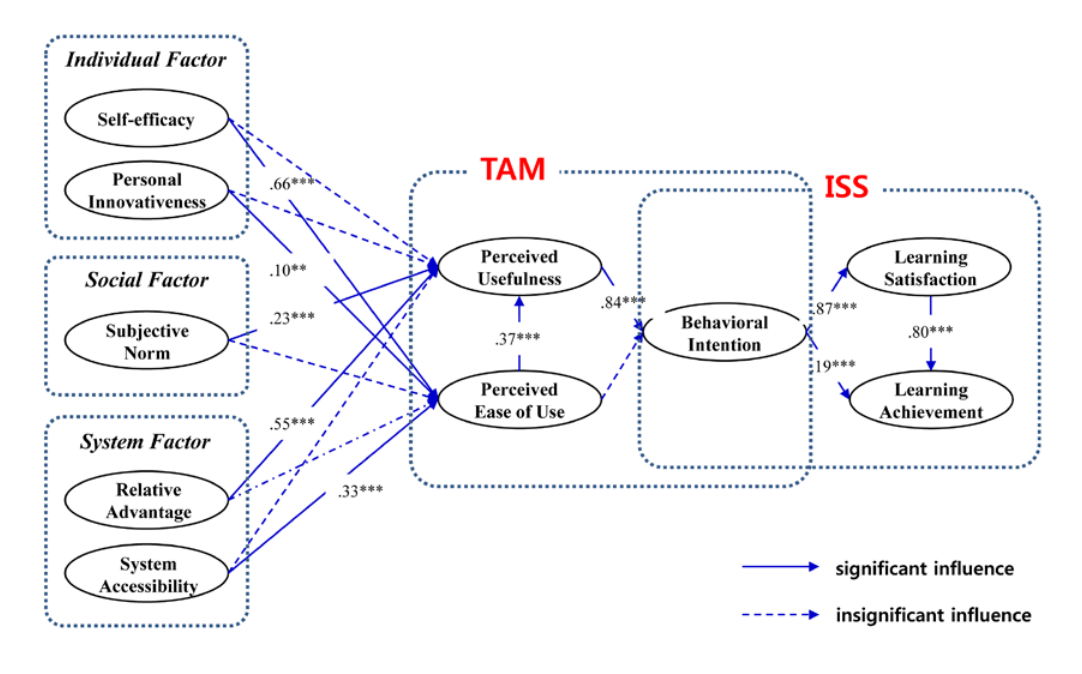
Figure 2 . Hypotheses test